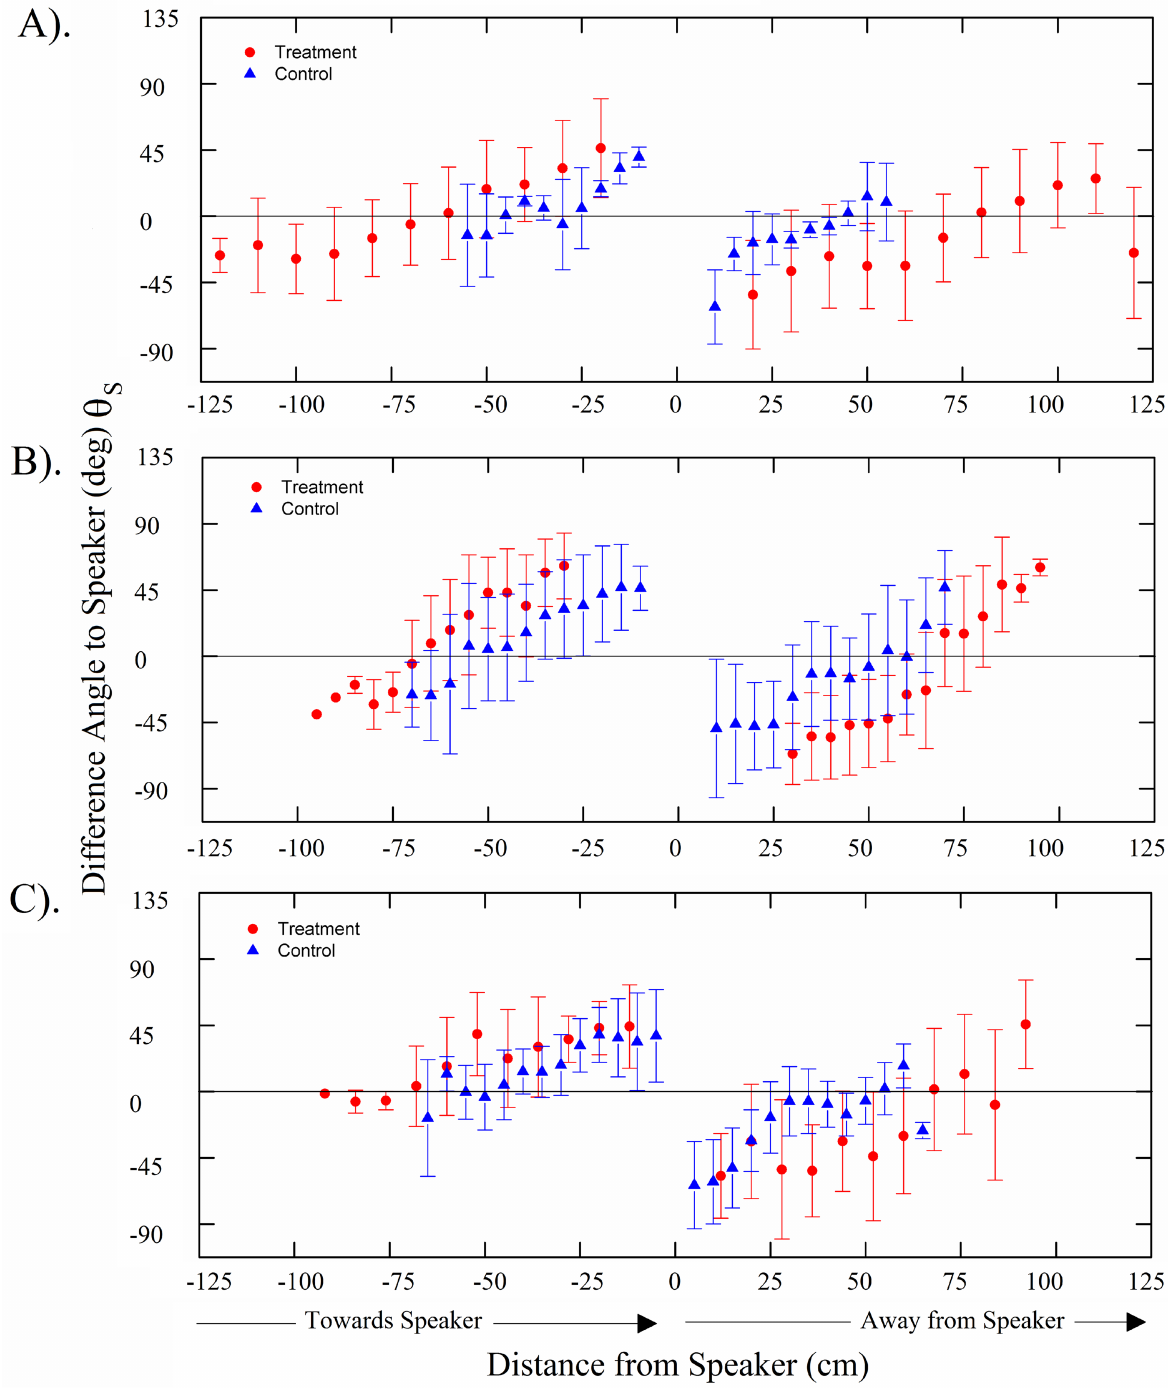
Fig 9. Differenceangles of fish bearing relative to the speaker for (A) common carp, (B) silver carp, and (C) bighead carp. Differenceangleswere calculatedalong swimmingtrajectoriesof fish that swam within 30-cm of an active speakerduringplayback (treatment ● ). Differenceanglesrelative to the speakerare providedfor 8 trajectories duringcontrol periods (control ▲ ). Trajectories were analyzedfrom all playbackstreatments. Negativedistances indicatemovement towards the speaker, whilepositive indicate movement away. Bars are the standard